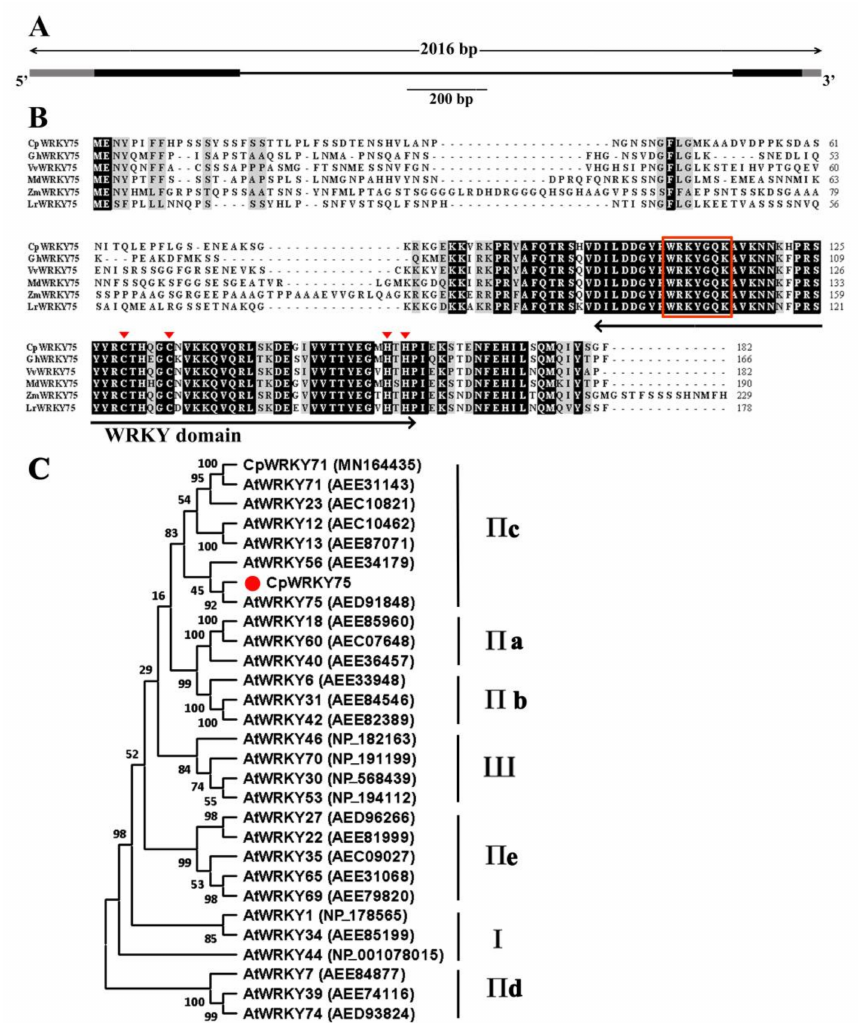
Figure 1. Sequence analysis of CpWRKY75 . ( A ) Gene structure of CpWRKY75 . Black boxes indicate ex- ons, lines indicate introns, grey boxes indicate untranslated regions. ( B ) Multiple sequence alignment of CpWRKY75 and the other WRKY proteins. Gossypium hirsutum GhWRKY75 (XP_016725404.1), Vitis vinifera VvWRKY75 (XP_002274387.1), Malus domestica MdWRKY75 (XP_008389898.1), Zea mays ZmWRKY75 (PWZ27788.1) and Lilium regale LrWRKY75 (ART33473.1) are from GenBank. The WRKY domain is marked by a two-headed arrow. The WRKY motif and the zinc-finger motif are marked by red box and red triangle, respectively. ( C ) Phylogenetic tree of CpWRKY75 and WRKYs from other plants. The phylogenetic tree was constructed by MEGA 11 software with the neighbor-joining (NJ) method (1000 BootStrap). The solid red circle shape indicates the position of